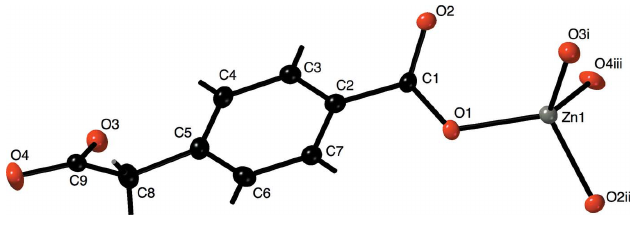
Figure 1 The distorted tetrahedral coordination environment of zinc(II) in the title compound. Displacement ellipsoids are drawn at the 50% probability level. H-atom positions are shown as sticks.